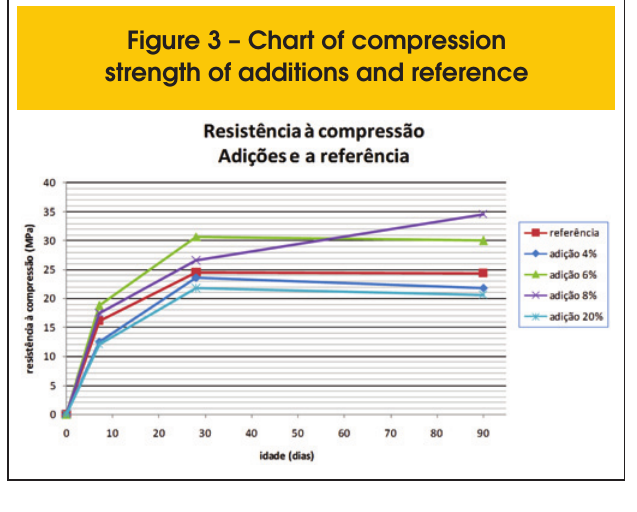
Figure 4 – Chart of compression strength of sand replacements and reference